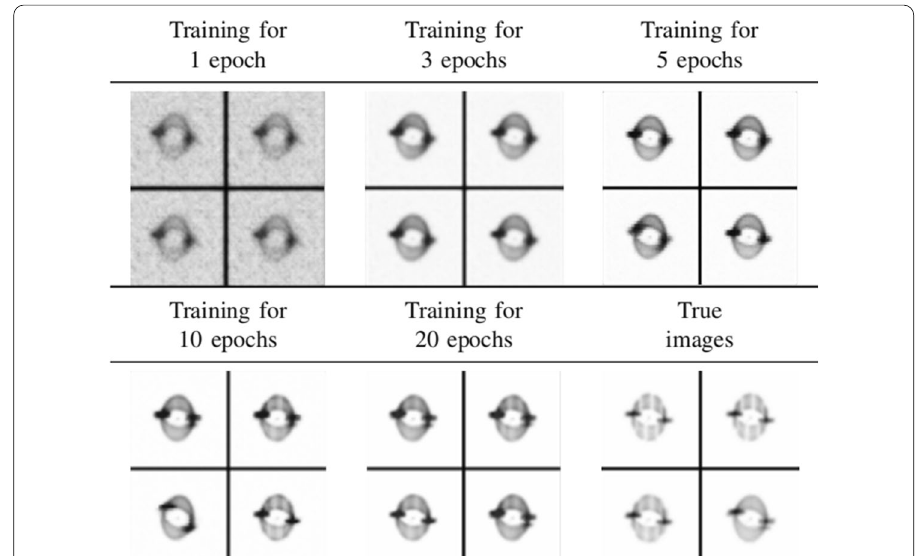
Fig. 8 DCTF generated by GAN after epochs of training. These figures show the generated DCTFs during the 20 epochs of training with 30 dB